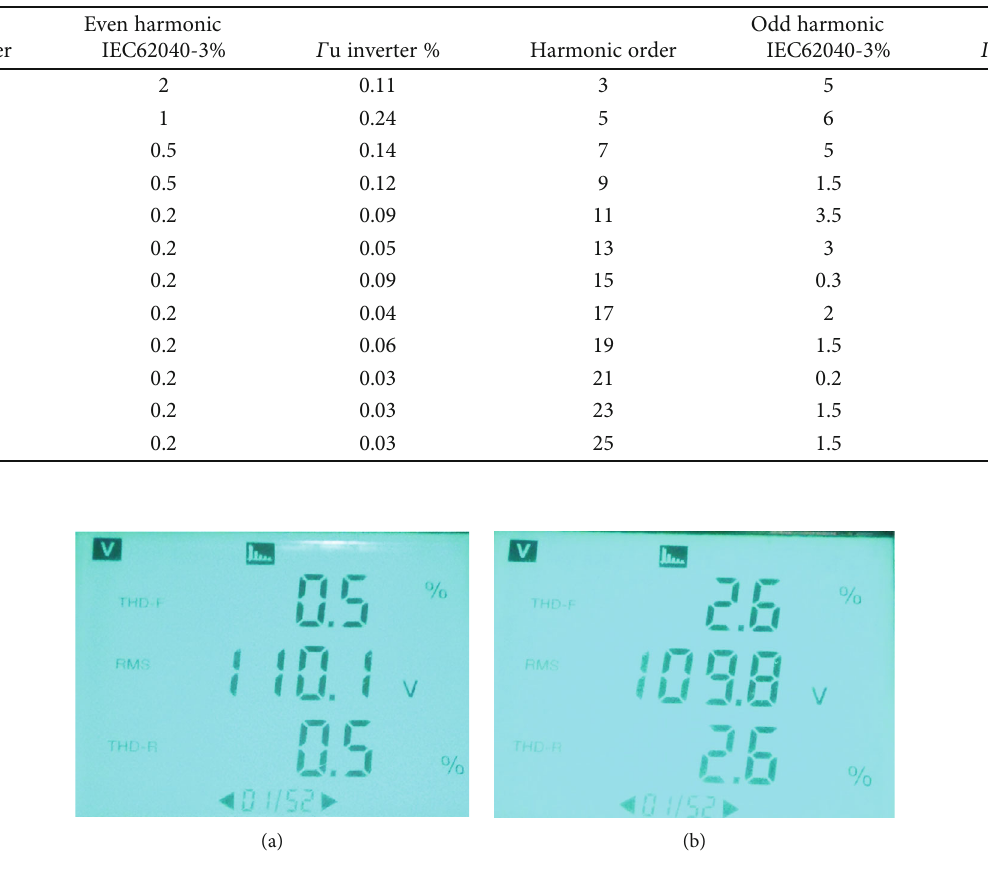
Table 6: Standard limit and individual harmonic of Γ u